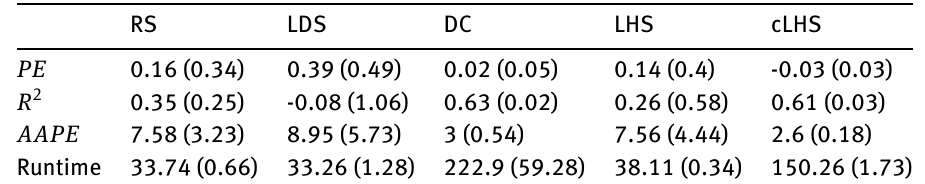
Table 4: Average accuracy and speed (in seconds) of the experimental design methods over 10 runs when s = 880 . The num- bers in parentheses are the corresponding standard deviations.